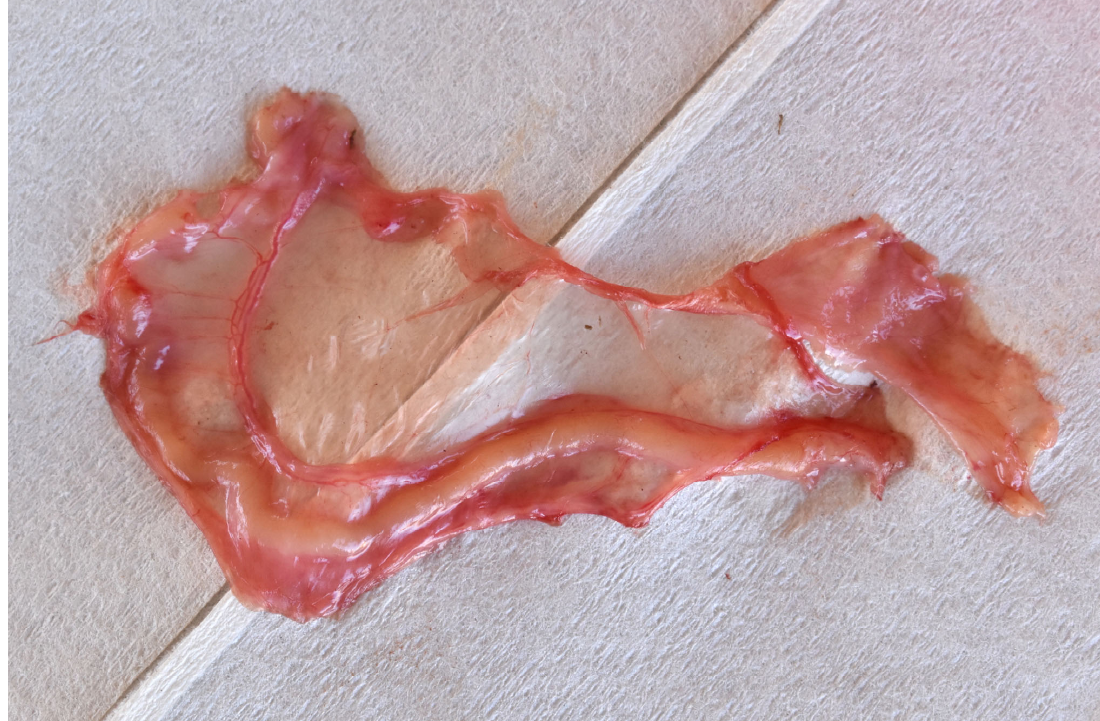
Figure 4. A section of mesosalpinx and uterine tube removed per vaginum .